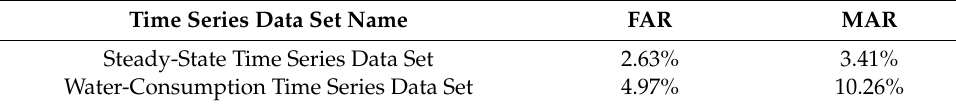
Table 2. Leakage detection results for two time series data